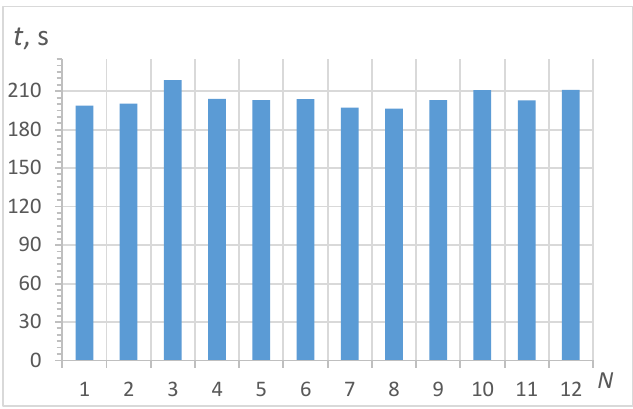
Fig. 11. Time spent for different quadcopters with an optimisation algorithm for 1000 m